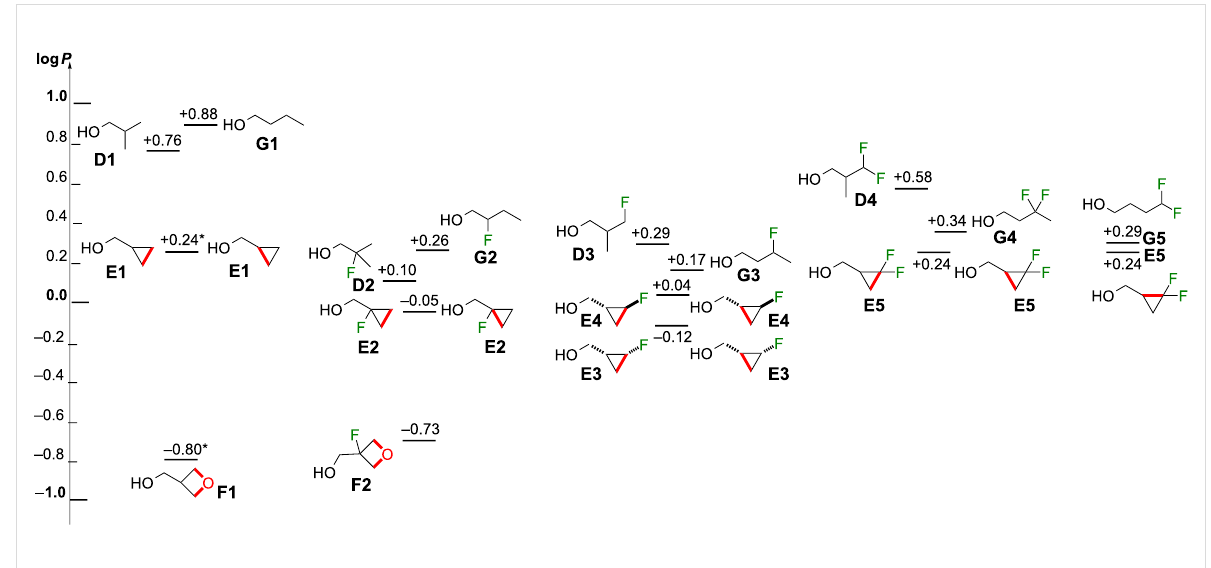
Figure 6: Comparison of lipophilicities between the linear alkyl, isopropyl, cyclopropyl, and 3-oxetanyl substituents by fluorination level (exchange two C–H bonds by a C – C bond or C – O – C bonds, same carbon count).